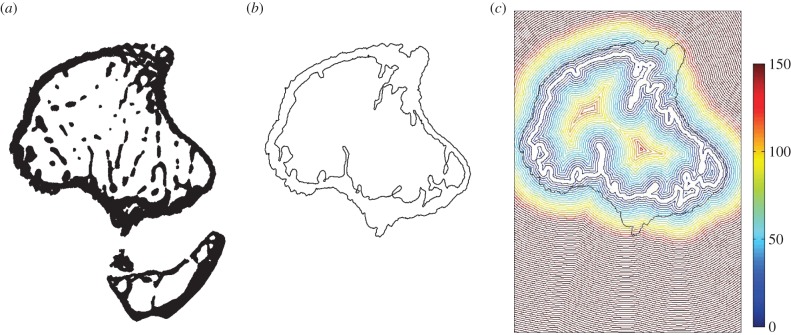
Steps of script for the calculation of cortical thickness and endosteal distance from the centroid. (a) Initial cross section, (b) peri- and endosteal boundaries and (c) map of distances from the endosteum (units in micrometres).